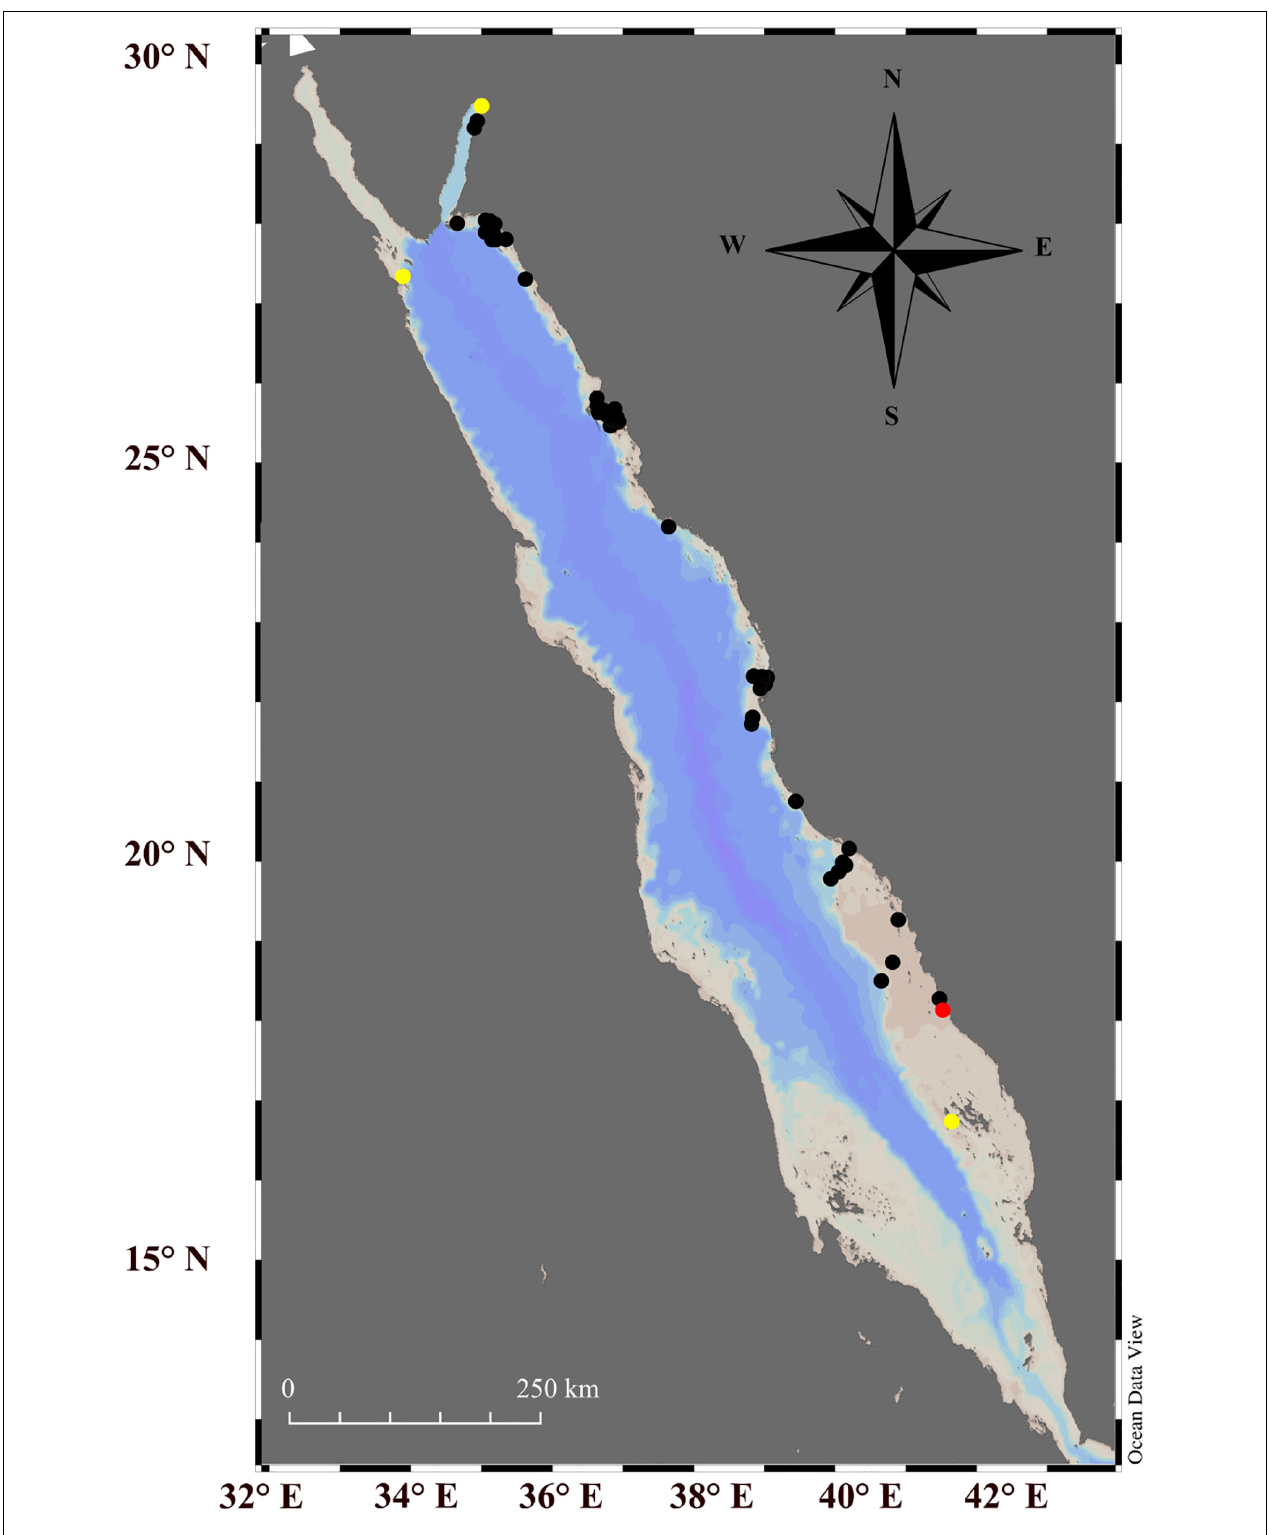
FIGURE 2 | Fifty-eight reefs studied during a large-scale giant clam survey along the eastern Red Sea (black and red dots). The red dot indicates the sampling site where the specimens of Tridacna squamosina were found and sampled for this study while yellow dots indicate the other three locations where T. squamosina were reported in the previous